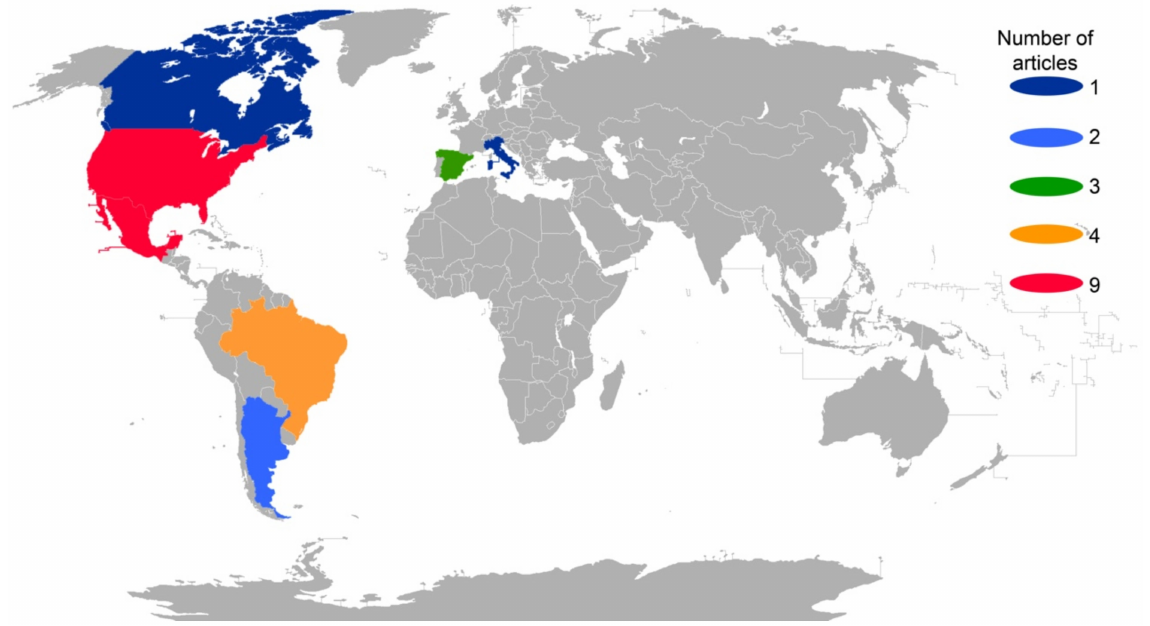
Figure 2. Number of retrieved studies published between 1911 and 2020 related to flower-visiting insects in Opuntia spp. by